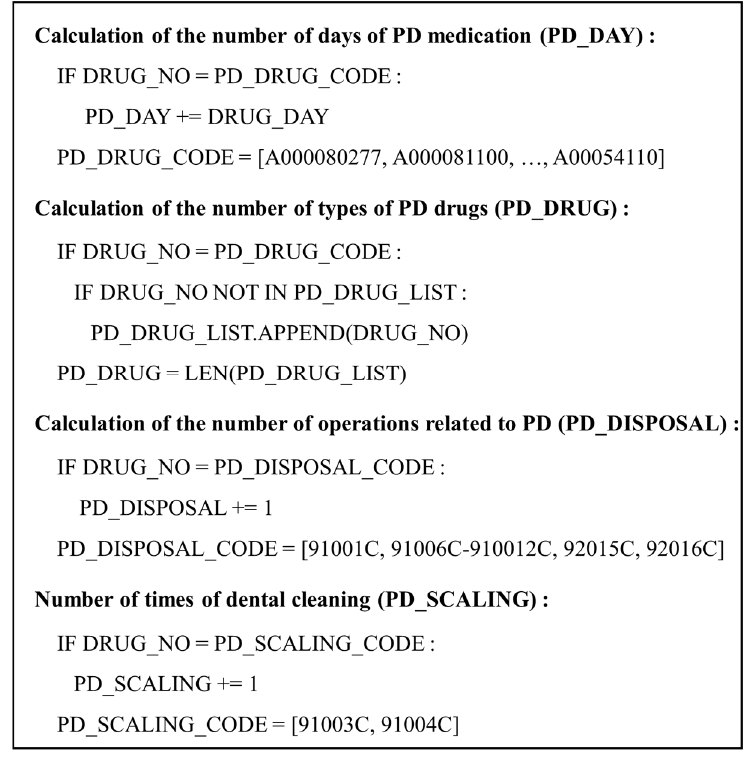
Figure 2. Schematic diagram of medical records.